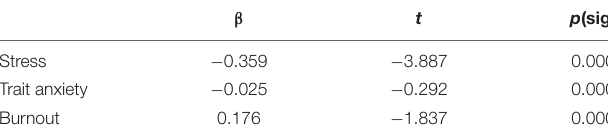
TABLE 6 | Regression values regarding the effect of stress, trait anxiety, burnout levels of healthcare professionals on their quality of life.